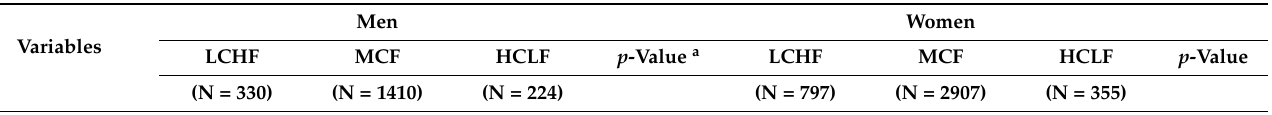
Table 2. Anthropometric and biochemical measurements of MetS and macronutrient intake of participants according to carbohydrate and fat